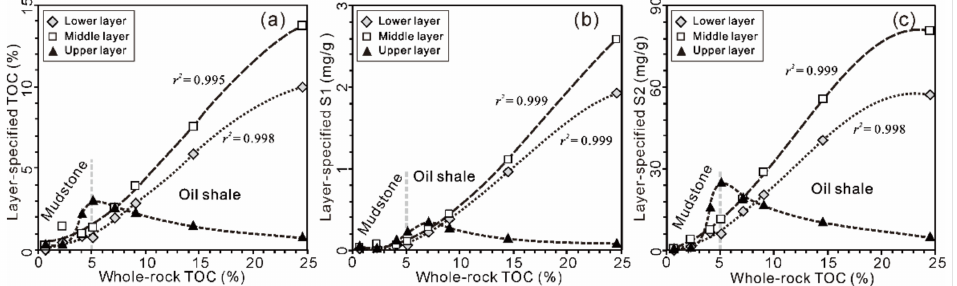
Figure 6. Correlations between whole-rock TOC contents and values of layer-specified TOC ( a ), layer-specified S1 ( b ), and layer-specified S2 ( c